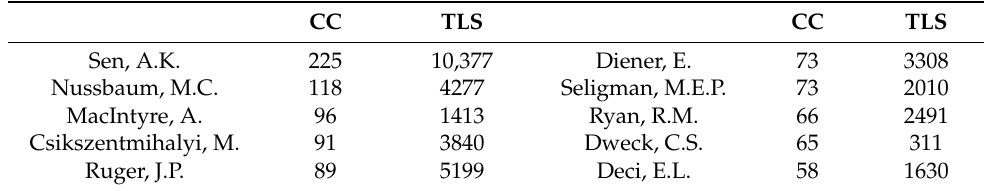
Table 9. HF: Co-citation and total link strength of the top 10 most cited authors.